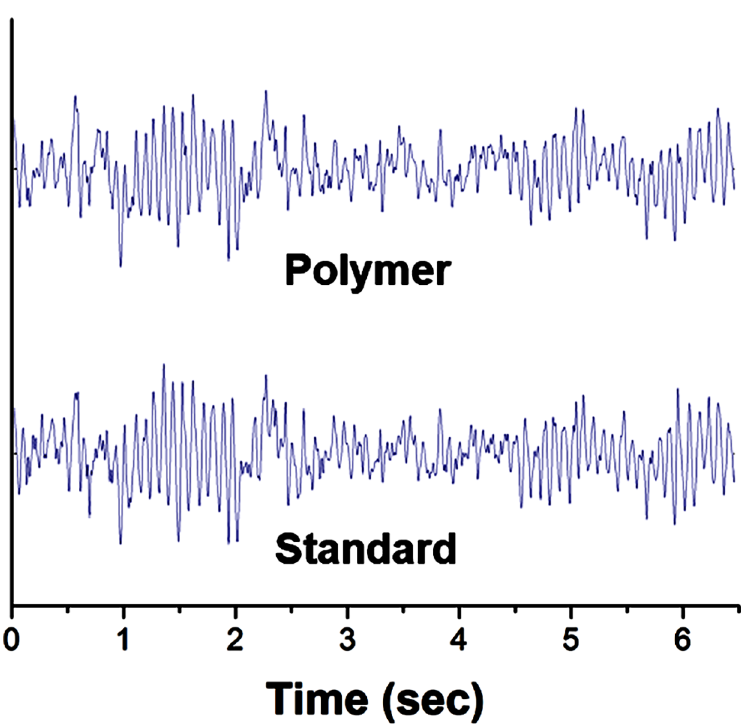
Fig 6. Sample time series of data recorded from paired 4% CNF-PDMS (top) and standard Ag-AgCl (bottom) from a sample human subject. Note high similarity in the fluctuation over